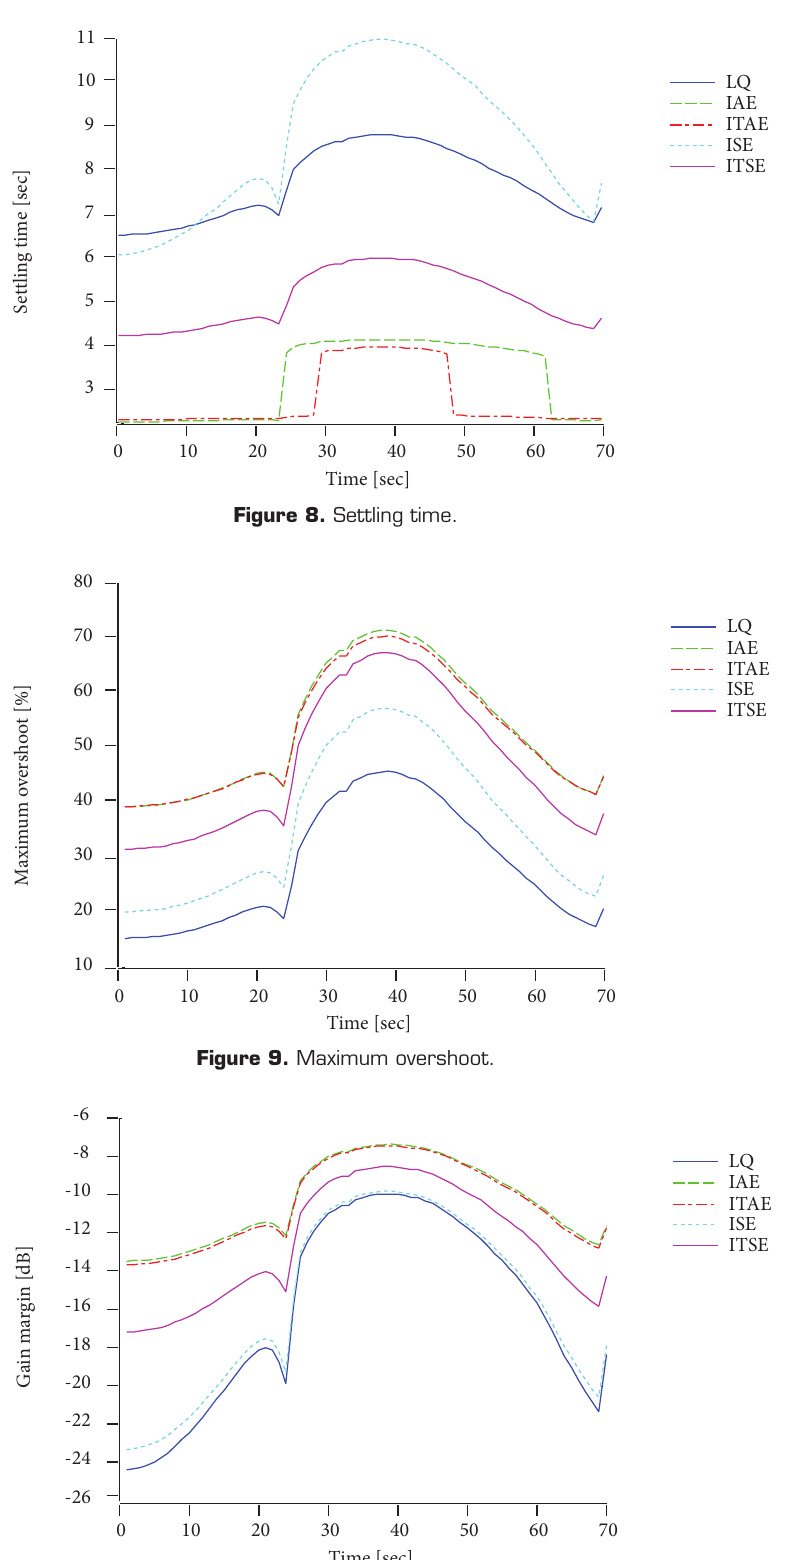
Figure 10. Gain margin.